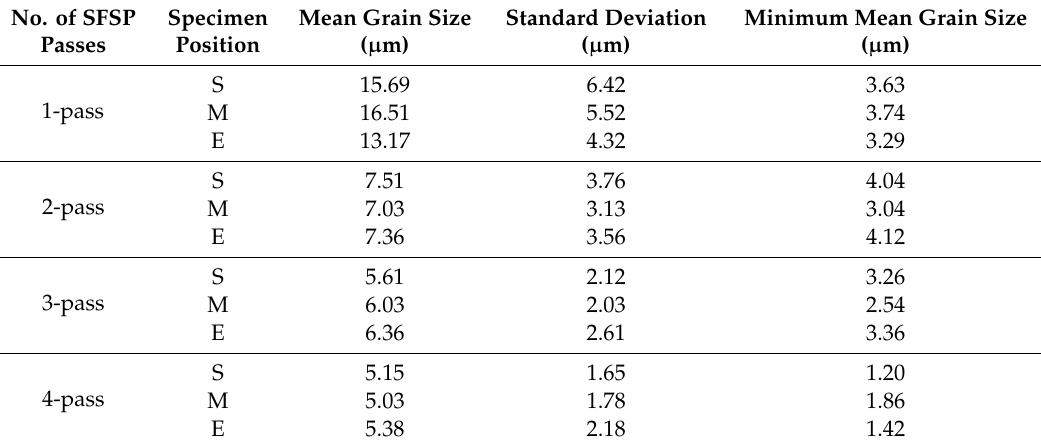
Figure 3. Multiple pass submerged friction stir-processed FSWed micrographs: 1-pass ( a ) start, ( b ) middle, ( c ) end; 2-pass ( d ) start, ( e ) middle, ( f ) end; 3-pass ( g ) start, ( h ) middle, ( i ) end; 4-pass ( j ) start, ( k ) middle, ( l ) end. Table 4. Measured grain sizes.